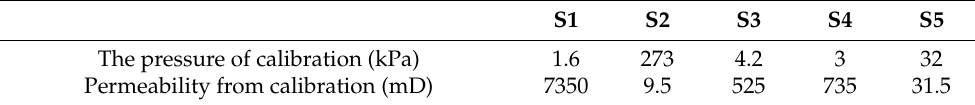
Table 1. The pressure of calibration and permeability from calibration.